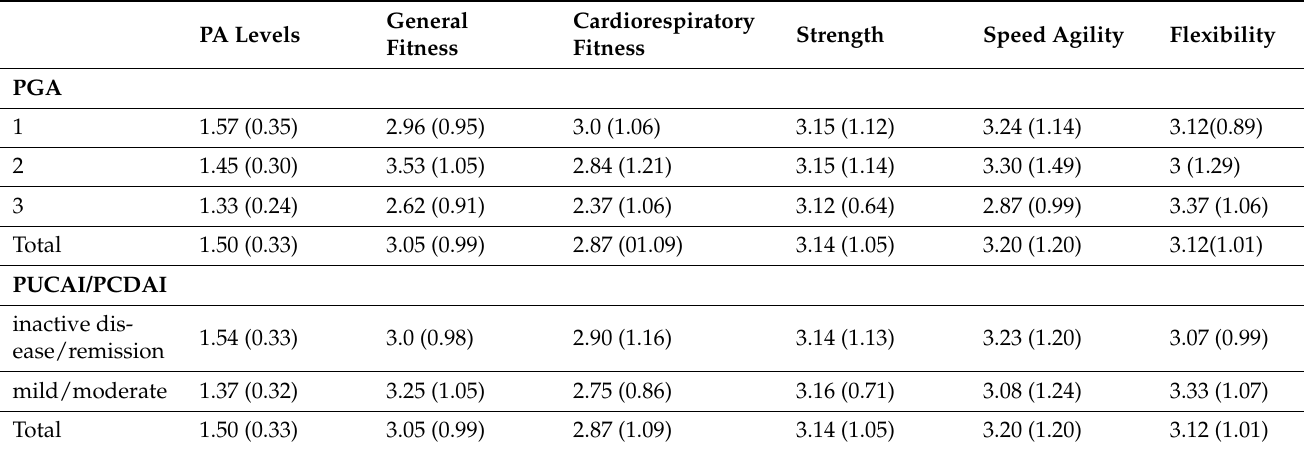
Table 2. Physical activity (PA) levels and physical competences in patients affected by IBD ac- cording to Physician Global Assessment (PGA) and Pediatric Ulcerative Colitis Activity Index (PUCAI)/Pediatric Crohn’s Disease Activity Index (PCDAI) were